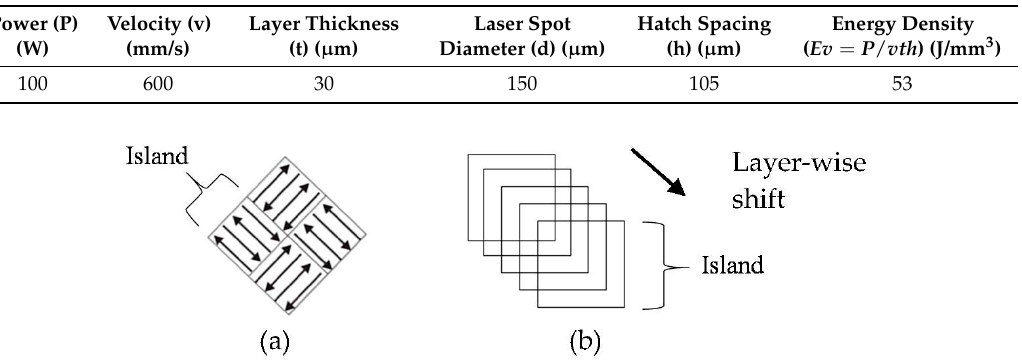
Table 2. Printing process parameters.